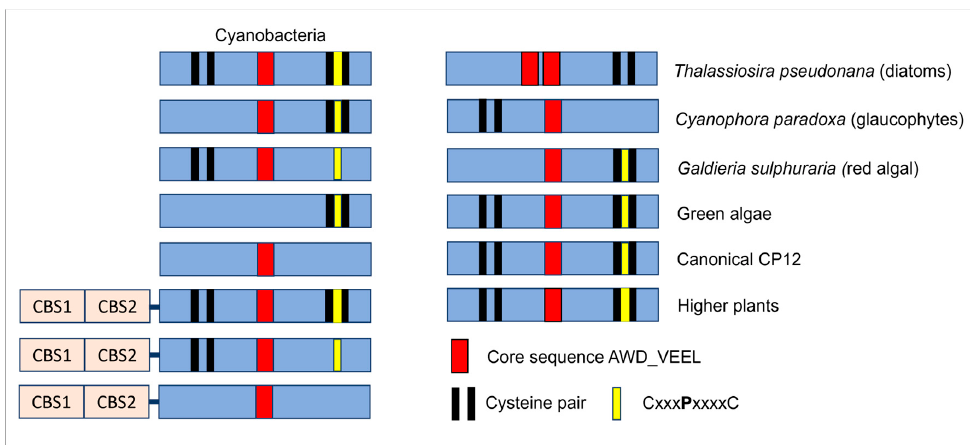
Figure 5. Schematic representation of structural variants of CP12. CBS (orange rectangles) stands for cystathionine β -synthase. The pairs of black lines represent cysteine residues pairs, the red rectangles represent the core sequences AWD_VEEL, and the yellow lines represent the central proline within the C-terminal residues pair. Adapted from D.N Stanley et al., 2013 [58]. In cyanobacteria, CP12 proteins fused to two cystathionine β -synthase (CBS) do- mains (CBS-CP12) were found beside the stand-alone CP12, and at present, CBS-fused CP12 has only been reported in these organisms. These CBS-proteins are widespread, and the analysis of 333 cyanobacterial genomes revealed the presence of many variants (Figure 5) [58].